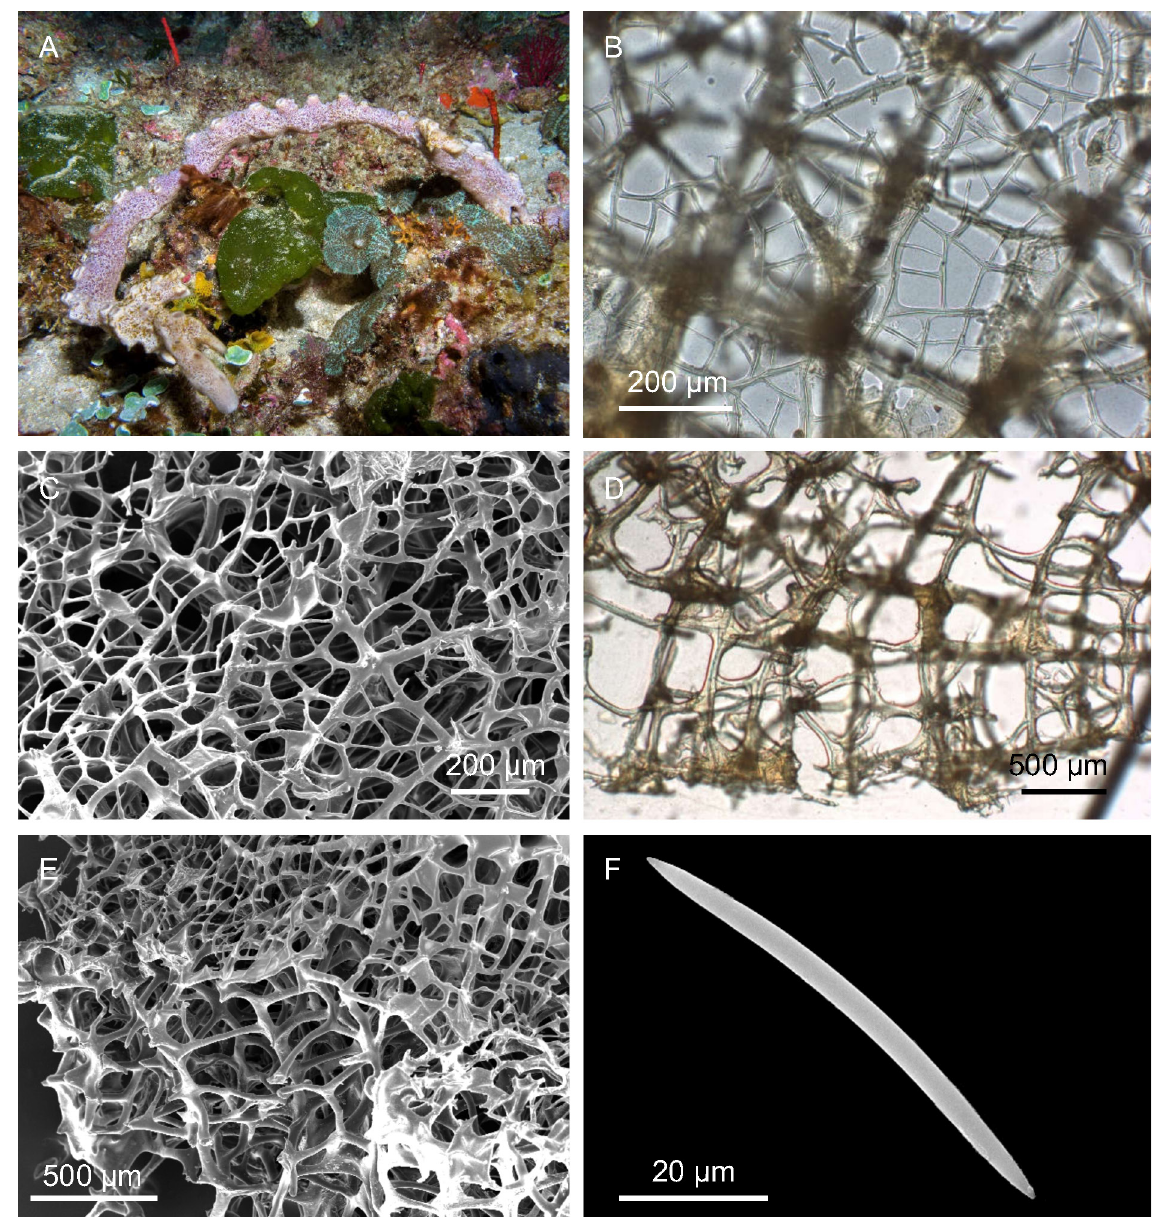
Fig. 8. Callyspongia ( Callyspongia ) pulitzeri Van Soest & Hooper, 2020. A . Specimen IMG0827 in situ . B . Ectosomal skeleton. C . SEM picture of the ectosomal skeleton. D . Ectosomal skeleton. E .